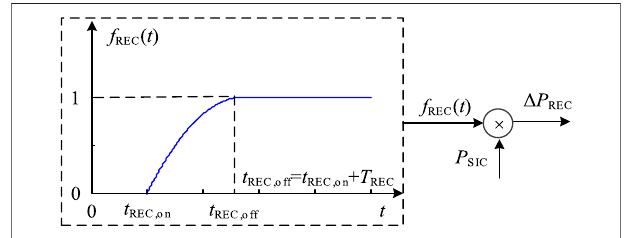
FIGURE4| Rotorspeedrecoverycontrolbasedondirectcompensation of auxiliary FR power.